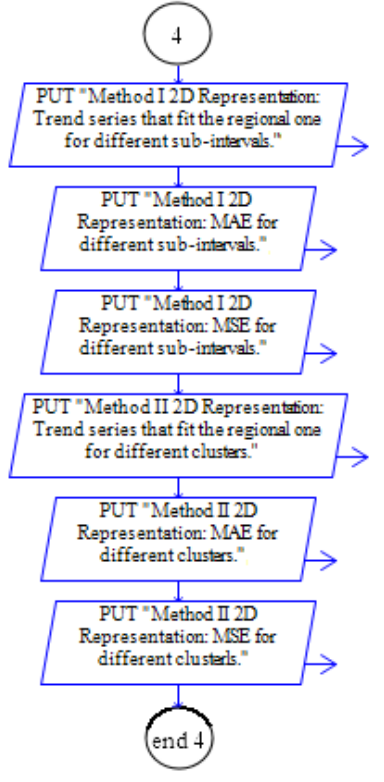
Figure 5. Comparison step.